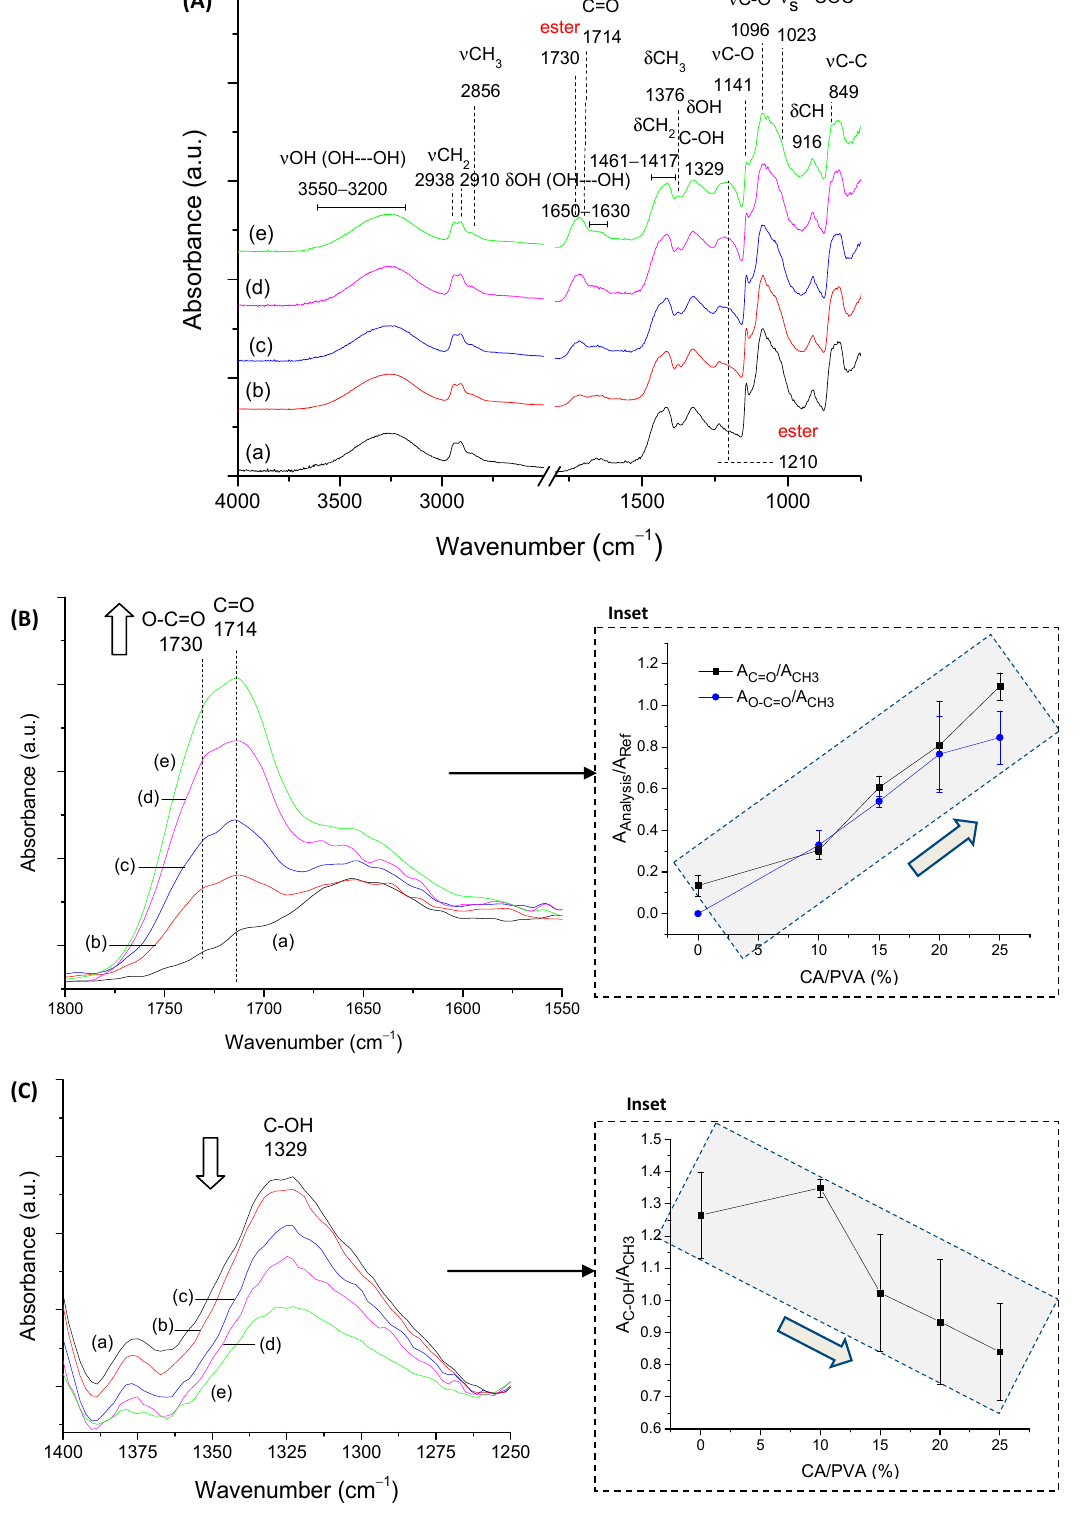
Figure 6. ( A ) FTIR spectra of PVA crosslinked with different amounts of CA/PVA: ( a ) 0%, ( b ) 10%, ( c ) 15%, ( d ) 20%, and ( e ) 25%. Evolution of ( B ) C=O (1714 cm − 1 ) and O-C=O (1730 cm − 1 ) (inset: A C=O /A CH3 and A O-C=O /A CH3 ratios), and ( C ) C-OH band (1390 cm − 1 , inset: A C-OH /A CH3 ratio). Arrows indicate the trend of the parameter/band.